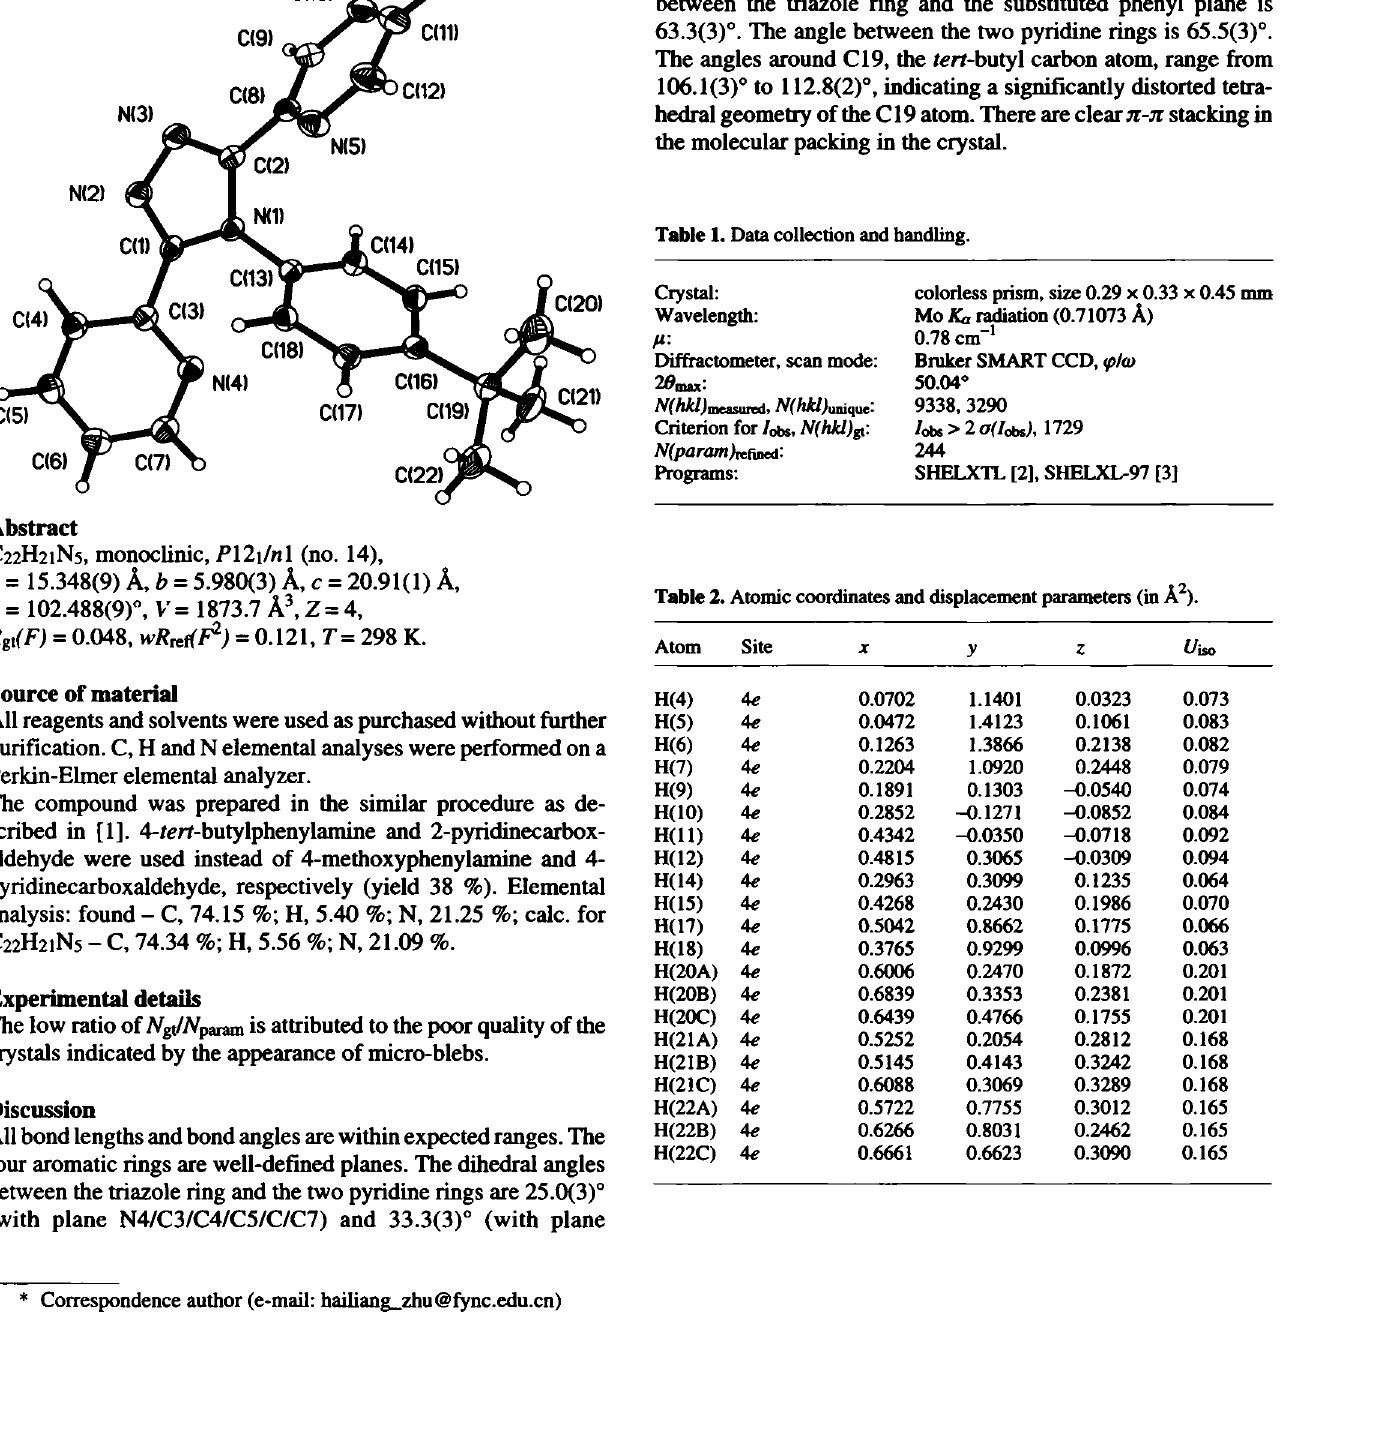
Table 1. Data collection and handling.